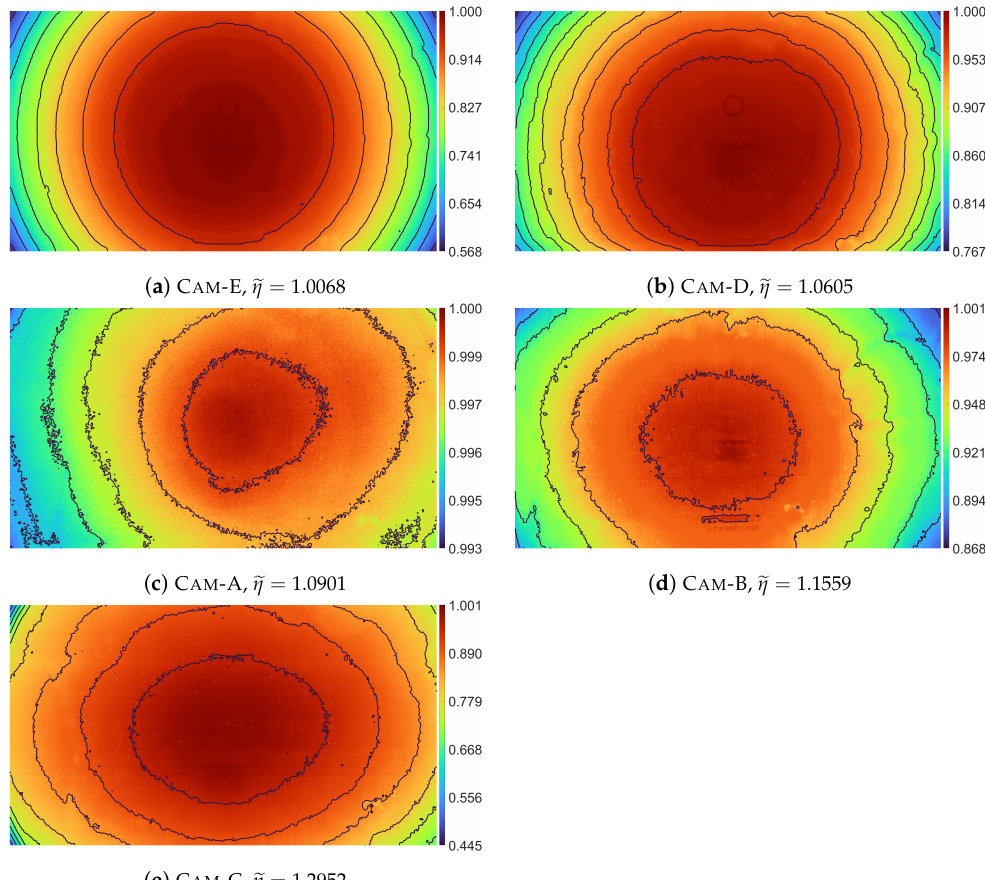
Figure 1. Comparison of the acquired images I V ; the images are presented in the order of the increasing non-radiality degree of vignetting, which is described by the (cid:101) η